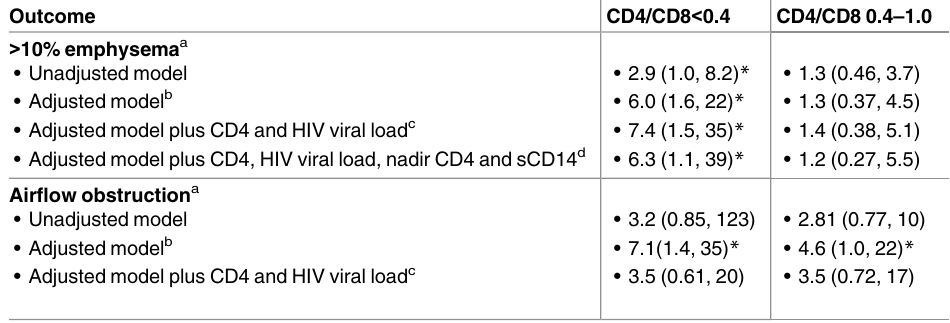
Table 3. Associations between CD4/CD8 ratio category(relativeto ratio > 1.0) with emphysema and air- flow obstruction in logistic regression